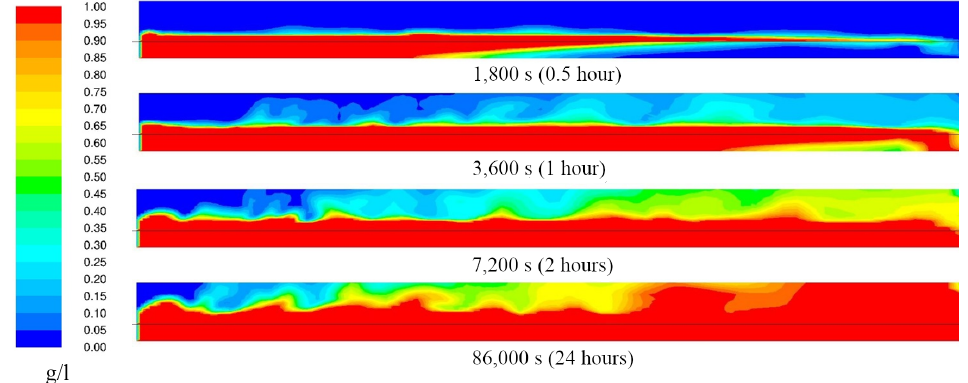
Figure 7. The impurity concentration field in a vertical section at the middle of the calculation domain. The concentration scale is from 0 to 1